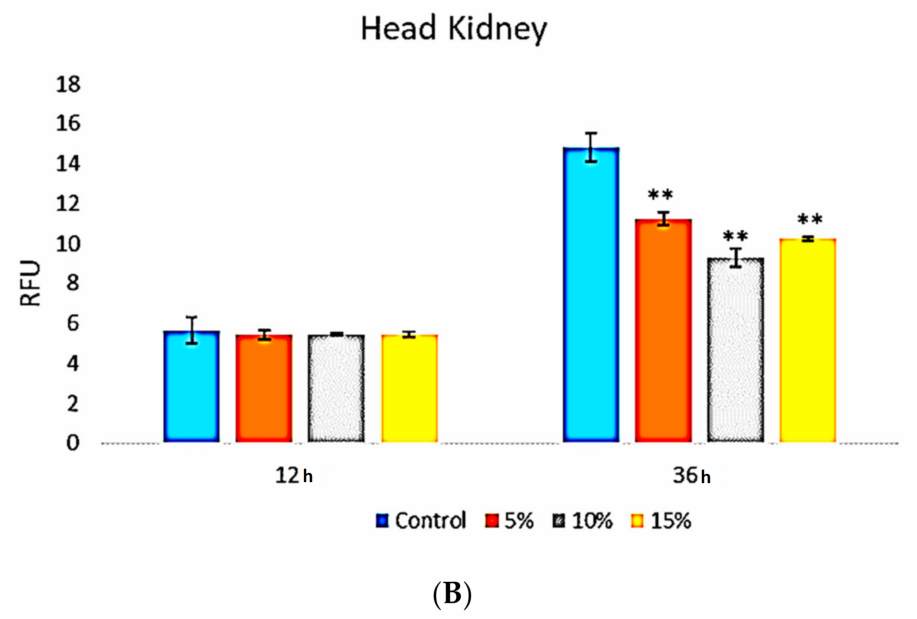
Figure 4. Effect of acetyl-xylogalactan on LPS-induced apoptosis. ( A ) Liver of Nile tilapia fed with acetyl-xylogalactan for 4 weeks was treated with LPS. ( B ) Head kidney of Nile tilapia fed with acetyl-xylogalactan for 4 weeks was treated with LPS. * p < 0.05; ** p < 0.01. All treatment groups were compared to the control group.